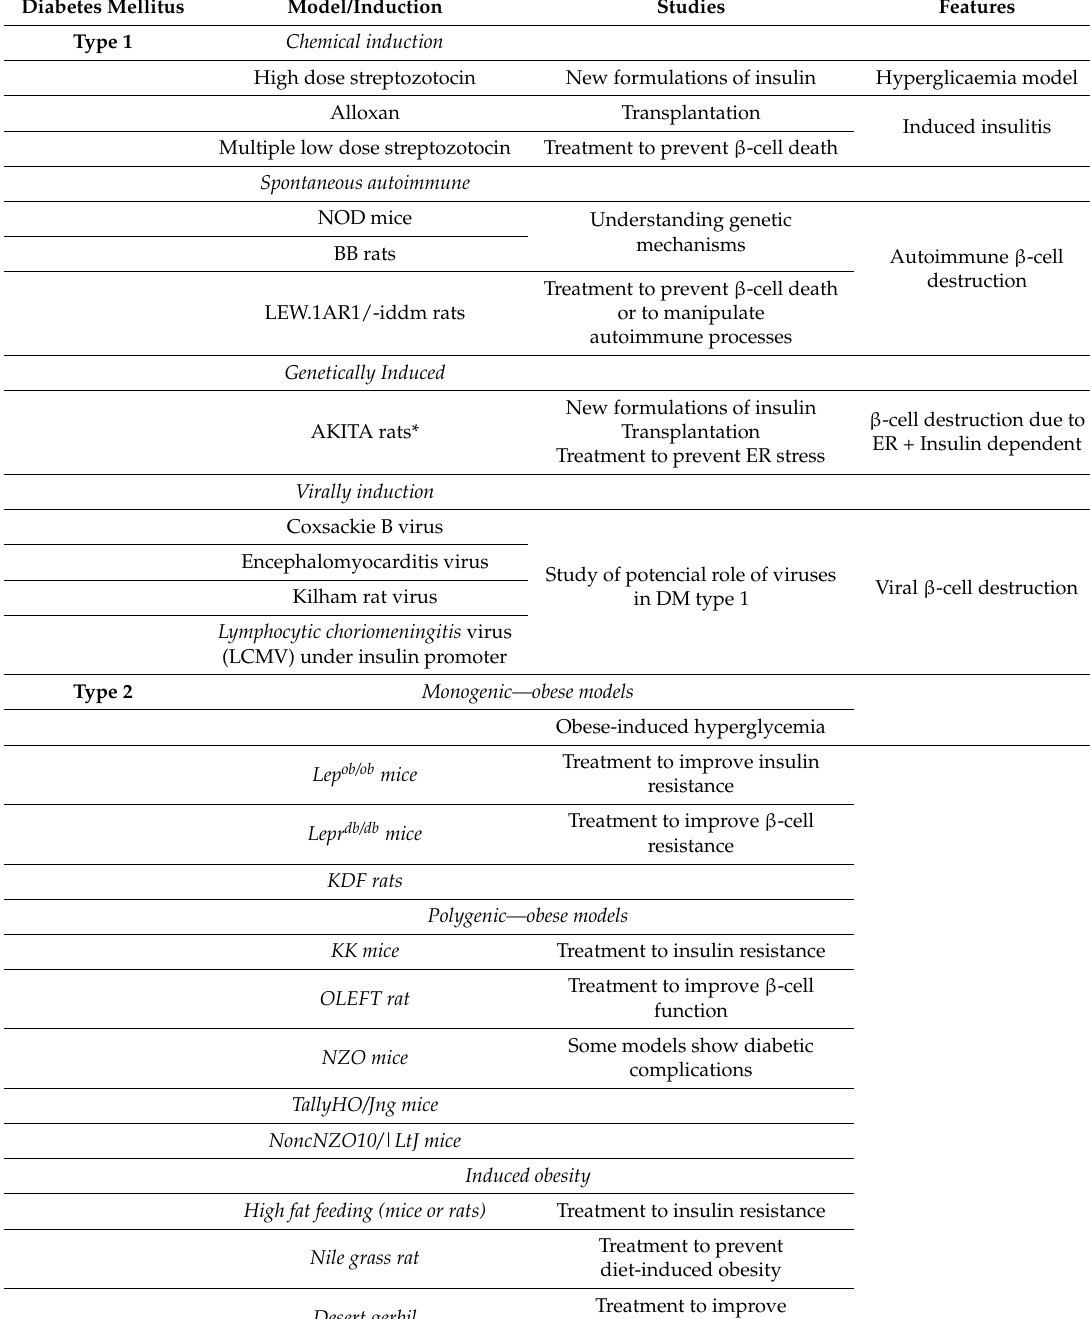
Table 6. Main animal models used in diabetes mellitus studies